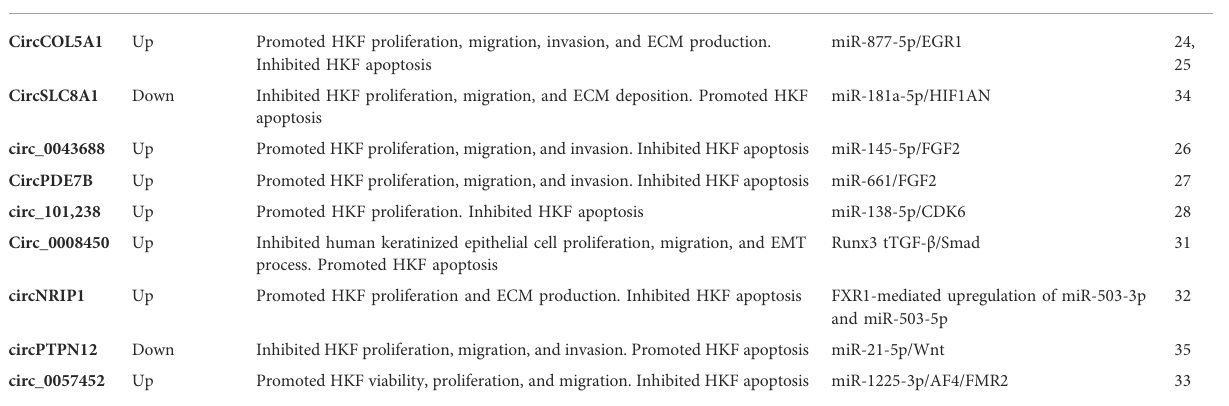
TABLE1 Expression and function of dysfunctional circRNA in